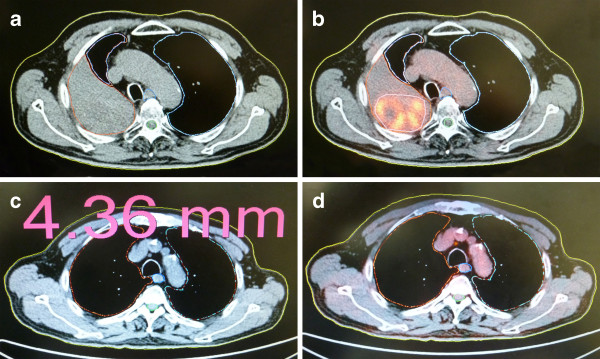
Comparison between conventional CT and PET-CT image. A: By conventional CT, it was difficult to distinguish the boundaries between incompletely expanded lung tissue and tumor tissue with consequent excessive target delineation. B: By PET-CT, the areas of high metabolic activity indicated the presence of tumors. The target volume was obviously smaller than that on conventional CT image. C: On conventional CT image, the mediastinal lymph node had a short-axis diameter of 4.36 mm and was not considered a metastatic lymph node. D: On PET-CT image, the mediastinal lymph node showed high metabolic activity and was considered a metastatic lymph node.